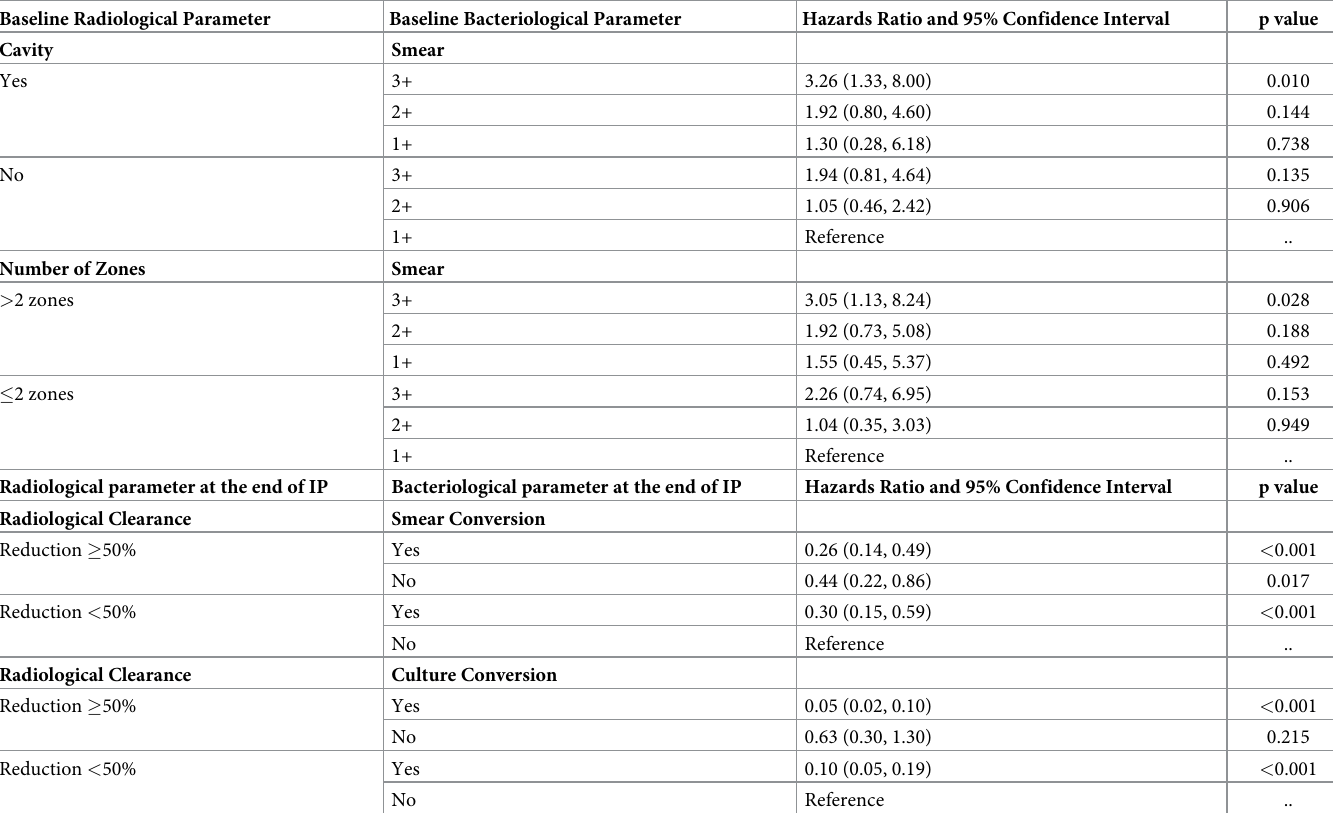
Table 3. Cox proportional hazards interactive model probing into the combined influence of radiological and bacteriological parameters in predicting an unfavour- able response: At baseline and end of intensive phase �